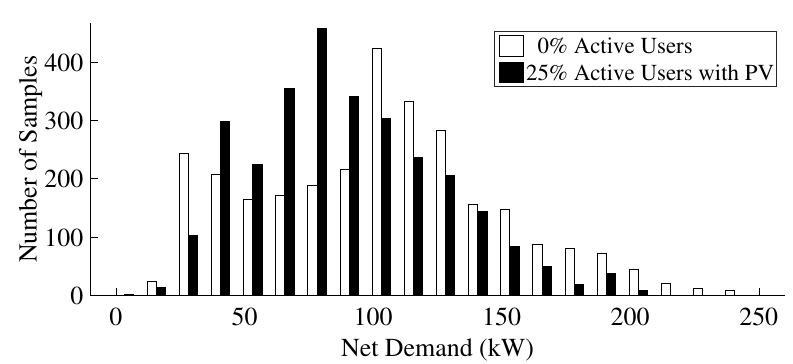
Figure 13. E net for the 25% active customers without PV. k